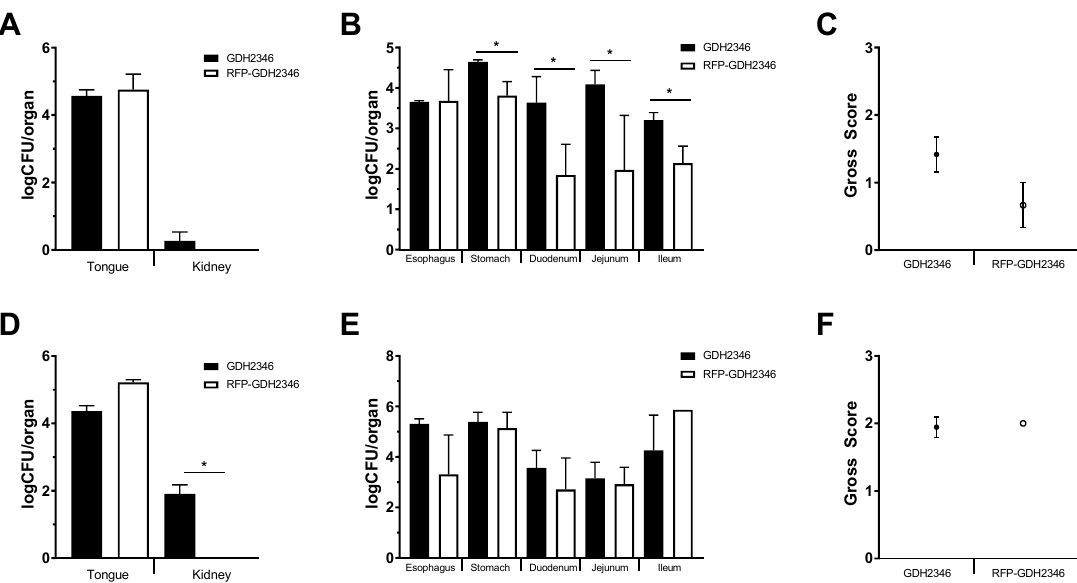
Figure 2. OPC infection of mice infected with GDH2346 versus GDH2346 ‐ RFP. Quantitative fungal burdens of tongues and kidneys of mice infected for 3 days ( A , D ); quantitative fungal burdens of esophagus and stomach, duodenum, jejunum and ileum ( B , E ); gross clinical pathology scores ( C , F ). Wild ‐ type mice ( n = 6 for GDH236; n = 3 for RFP) are shown in the upper panels ( A – C ) and IL1r1 − / − mice ( n = 12 for GDH236; n = 3 for RFP) are shown in the lower panels ( D – F ). *, p < 0.05.